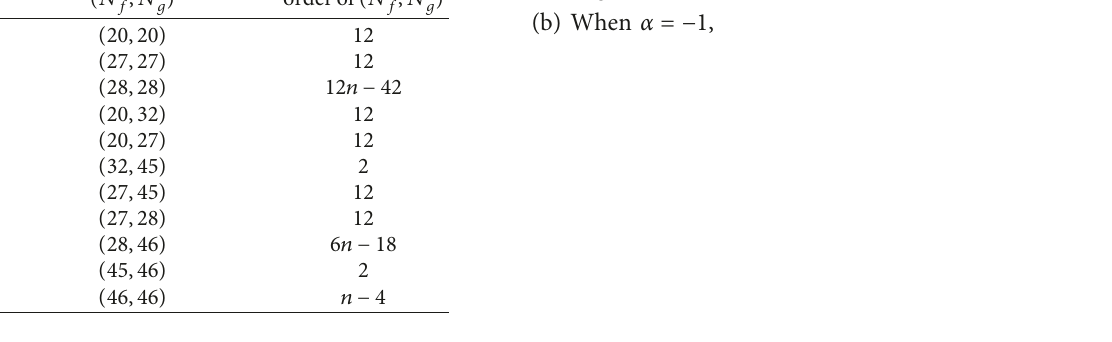
Table 2: Neighborhood degree-based edge partition. Edgenotation ( N f ,N g ) order of ( N f , N g